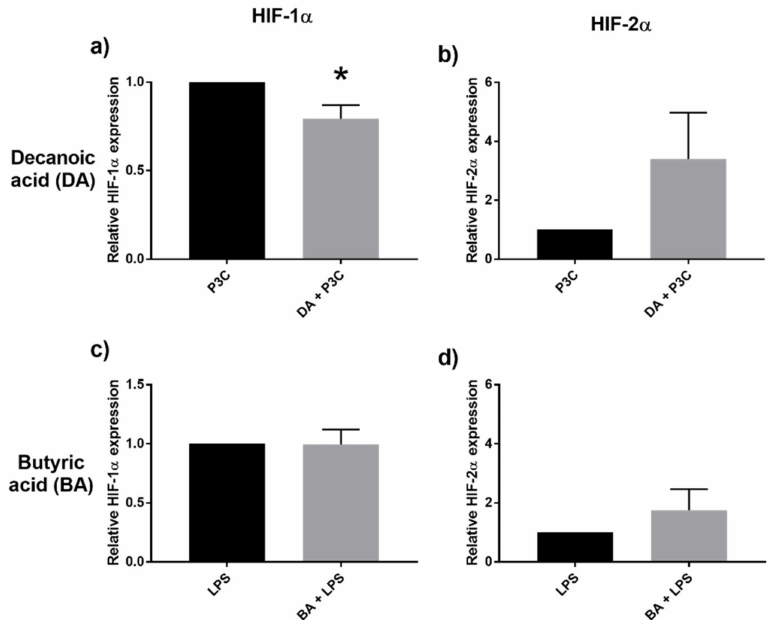
Figure 6. Relative expression of HIF1 α ( a ), HIF2 α ( b ) after stimulation with decanoic acid (DA) 20 µ M and P3C, and after stimulation with butyric acid (BA) 20 µ M and LPS ( c , d ), assessed by qPCR. Values are presented as mean ± SEM, results from at least 7 subjects were used. * p < 0.05 is the gene expression difference compared to the respective control (P3C/LPS) groups (black bar, normalized to 1), Wilcoxon signed rank test was used to determine